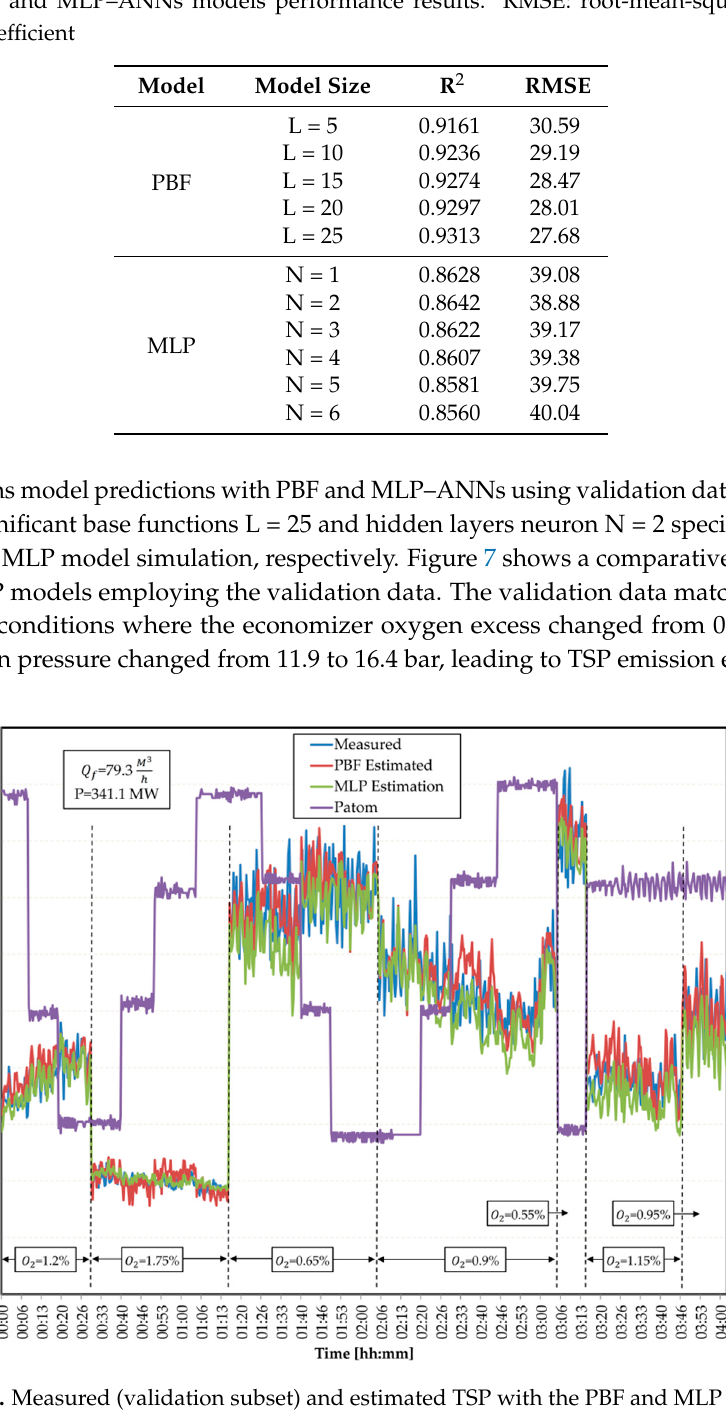
Figure 8. TSP emission models performance.